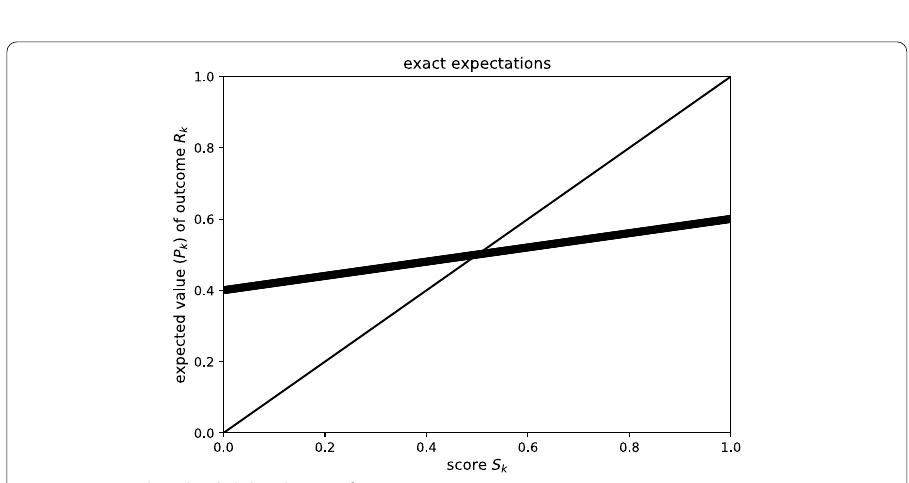
Fig. 31 Ground-truth reliability diagram for Figure